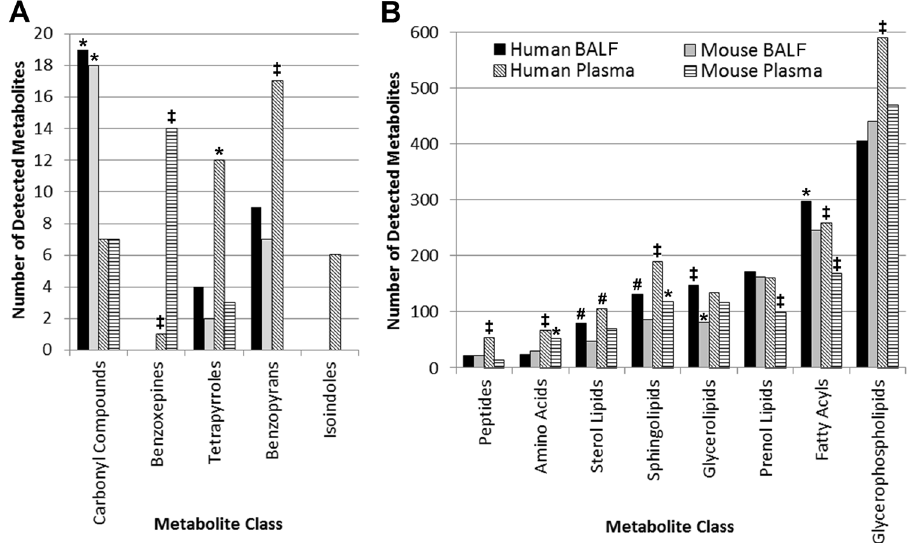
Figure 3. Metabolite coverage based on compound class for BALF and plasma in mouse and human samples. Indicated classes passed a proportional test used to analyze the metabolites in each of the four indicated groups; * p < 0.05; # p < 0.01; ‡ p < 0.001. Metabolite class categories were determined using the Human